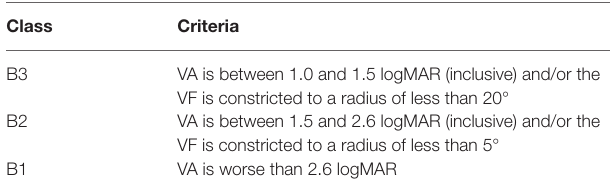
TABLE 1 | The criteria for the three sports classes for athletes with vision